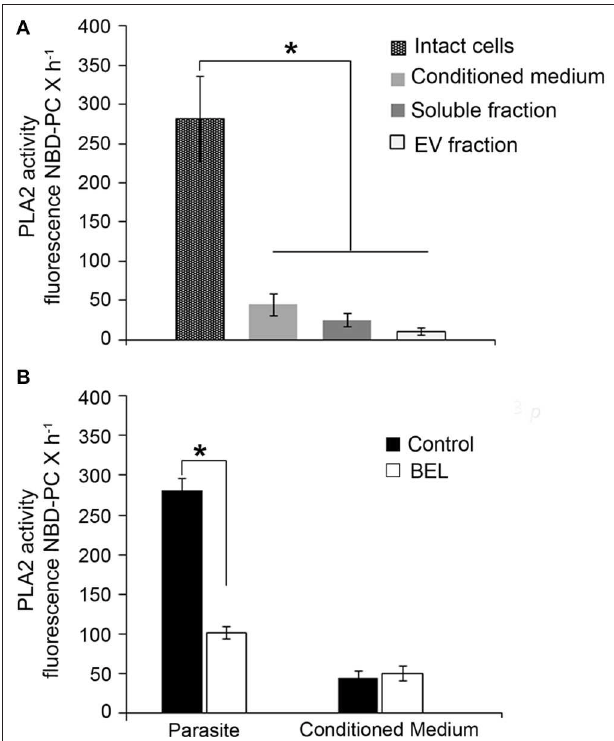
FIGURE 2 | Phospholipase A 2 (PLA 2 ) activity in promastigotes of Leishmania amazonensis. (A) PLA 2 activity was assayed in intact cells, in conditioned medium (from 2 × 10 8 promastigotes incubated in HBSS for 4h, 26 ◦ C), and in soluble and extracellular vesicle (EV) fractions obtained from the conditioned medium, using the fluorogenic substrate 6C-NBD-PC. (B) Effect of the inhibitor in the PLA 2 activity of intact cells and conditioned media. Fluorescence measured as above was continuously monitored for 60min 26 ◦ C in control untreated samples and in BEL treated promastigotes. Cells were treated with the inhibitor for 1h, and then incubated for 3h in culture medium lacking inhibitor. Data represent mean ± SEM values from three independent experiments, performed in triplicates (* p <